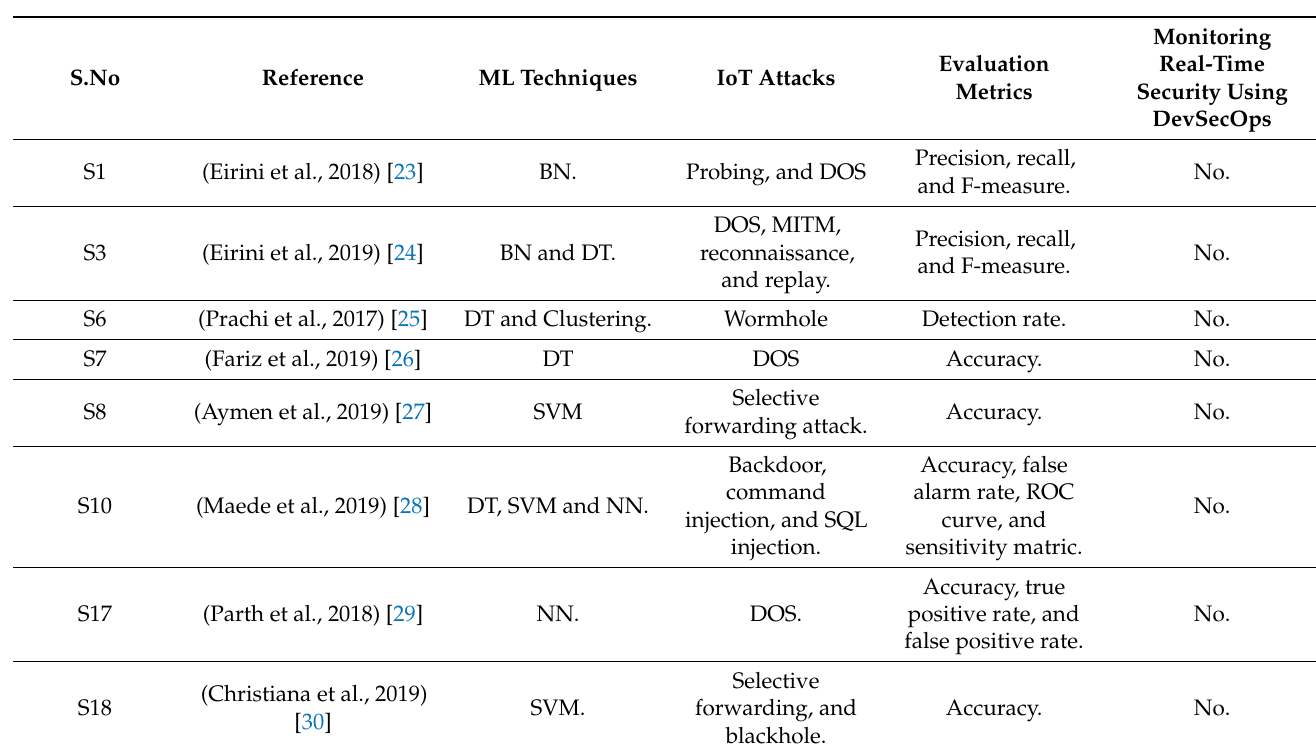
Table 4. Internet of Things (IoT) device testbed